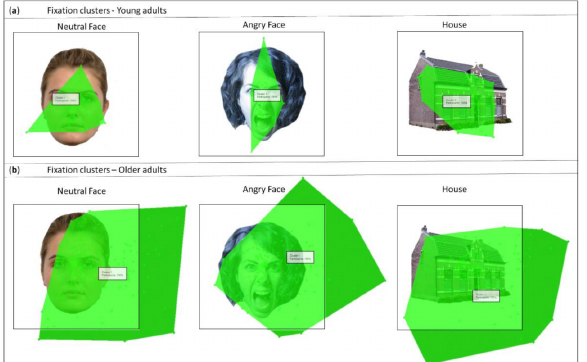
Figure 7. Graphic representation of areas with high concentrations of gaze data points (clusters). ( a ) Fixation clusters for the young adults group. From left to right: neutral face, angry face, and house. ( b ) Fixation clusters for the older adults group. From left to right: neutral face, angry face, and